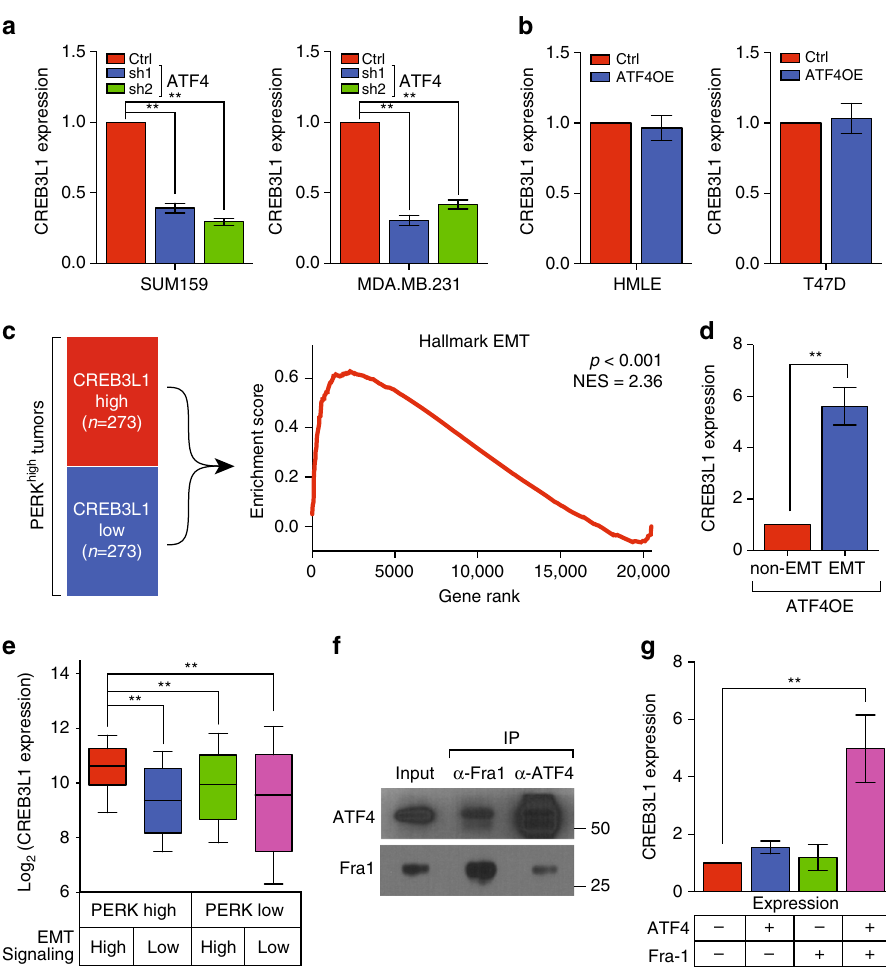
Fig. 5 PERK signaling requires an EMT to upregulate CREB3L1. a qPCR showing the relative expression of CREB3L1 in SUM159 and MDA.MB.231 cells transduced with shRNAs targeting luciferase or ATF4, n = 3. Data are represented as mean ± SEM. * indicates p < 0.05; ** indicates p < 0.01 (Student ’ s t -test). b qPCR showing the relative expression of CREB3L1 in HMLE and T47D cells transduced with a control plasmid or ATF4-expressing plasmid (ATF4OE), n = 3. Data are represented as mean ± SEM. * indicates p < 0.05; ** indicates p < 0.01 (Student ’ s t -test). c A set of 546 breast cancers (TCGA) expressing high levels of PERK pathway genes (PERK high tumors, see “ Methods ” section for details) were strati fi ed into CREB3L1-high and CREB3L1-low cohorts, according to the expression of CREB3L1. Gene set enrichment analysis using the hallmark gene sets was performed to compare the CREB3L1-high and CREB3L1-low tumors (left). The top hallmark gene set was an EMT set (right). d qPCR showing the relative expression of CREB3L1 in HMLE cells overexpressing ATF4 with or without induction of an EMT, n = 3. Data are represented as mean ± SEM. * indicates p < 0.05; ** indicates p < 0.01 (Student ’ s t -test). e Expression of CREB3L1 in breast cancers (TCGA) that have differential levels of PERK signaling and EMT signaling as indicated. Data are represented as a box-and-whiskers plot, n = 122. * indicates p < 0.05; ** indicates p < 0.01 (Mann – Whitney U -test). f HMLE cells were transduced with ATF4 and Fra-1 expressing constructs. Western blot for ATF4 or Fra-1 after immunoprecipitation of either ATF4 or Fra-1, which shows that these factors co-immunoprecipitate each other. g qPCR showing the relative expression of CREB3L1 in HMLE cells overexpressing control, ATF4, Fra-1, or a combination of ATF4 and Fra-1, n = 3. Data are represented as mean ± SEM. * indicates p < 0.05; ** indicates p < 0.01 (Student ’ s t